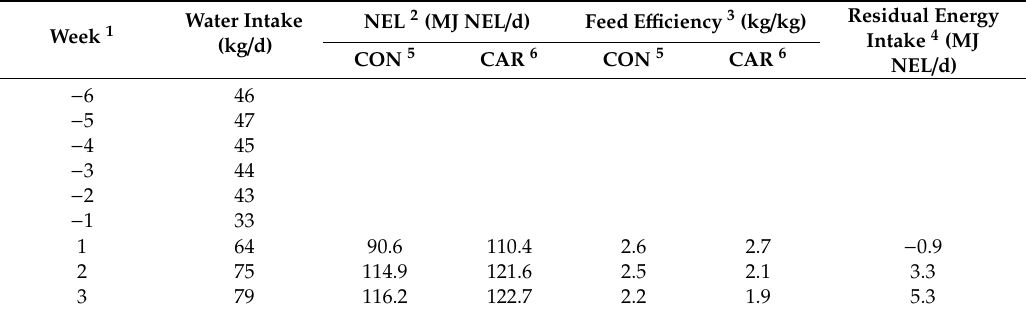
Table A2. E ff ects of an L-carnitine supplementation on water intake, net energy requirement for lactation (NEL), feed e ffi ciency and residual energy intake